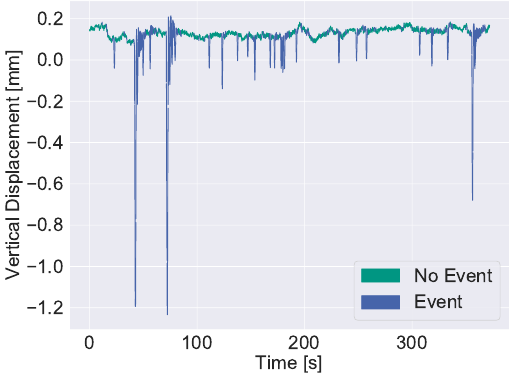
Figure 9. The vertical displacement of an unknown range bin at Bridge A and a different GBR position at this bridge as a time series over about 350s . The event classification is shown as result of the voting classifier (RF and